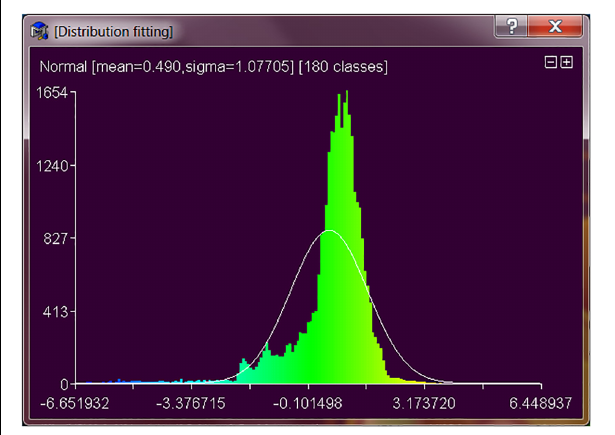
FIGURE 4 | Distribution from 3D